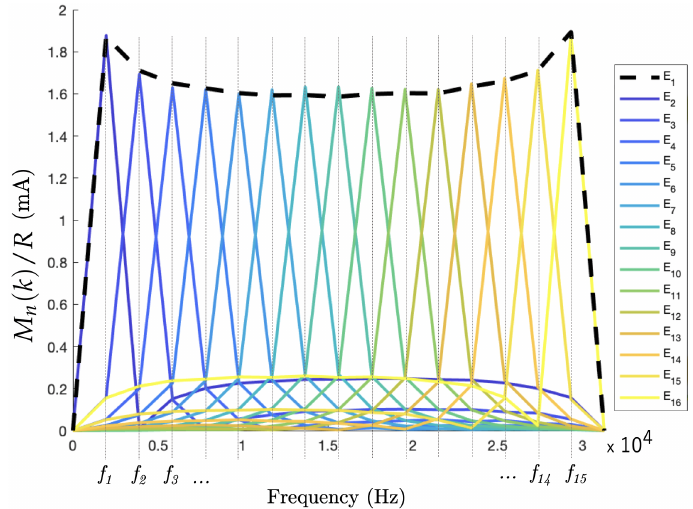
Figure 7. Measured current, represented as the magnitude of the DFT of 16 voltages over resistances in the excitation circuit of the 16 electrodes. This result corresponds to excitations in the low harmonic domain.